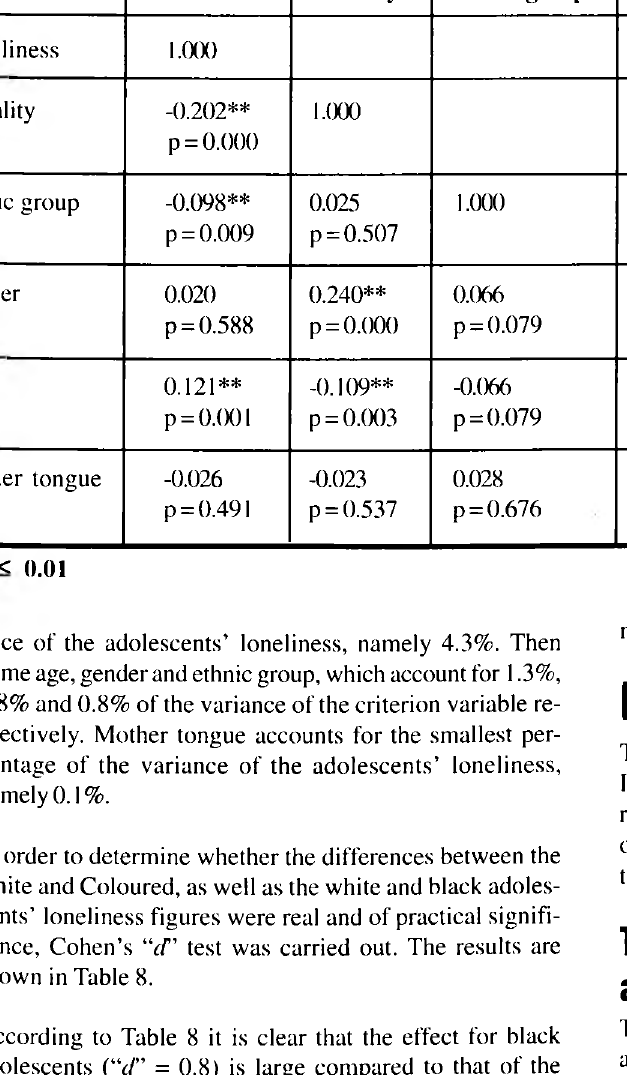
Table 6: Contributions of the different variables to R2 with regard to